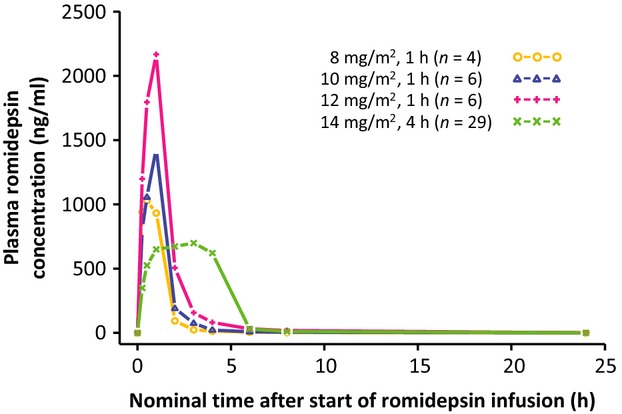
Median plasma romidepsin concentration versus time.